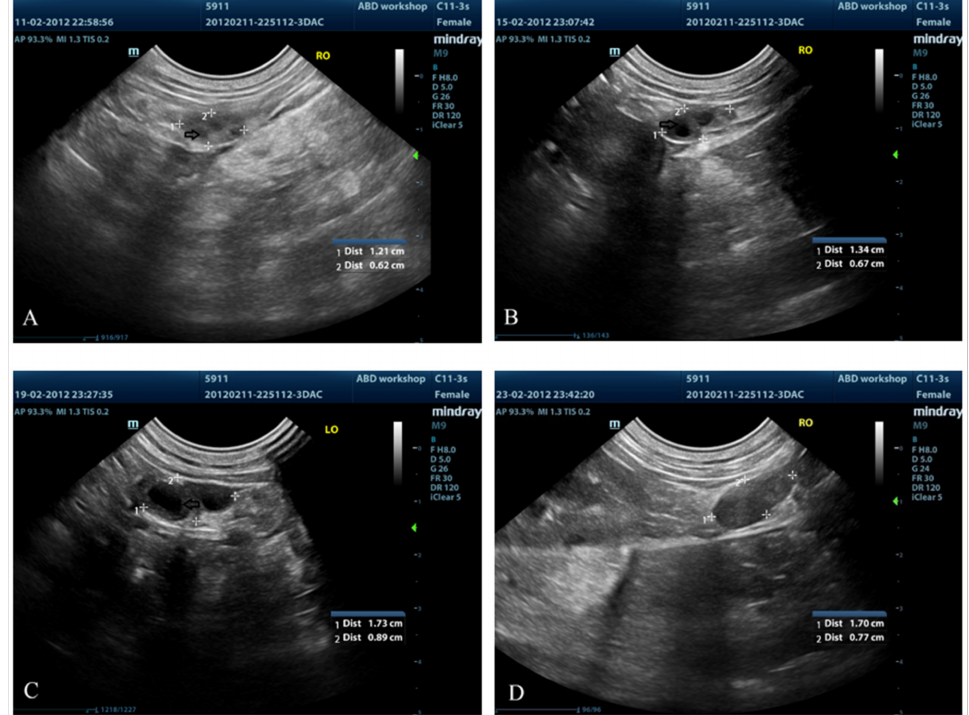
Figure 3. Examples of ovarian ultrasound images showing changes in size of the anechoic fluid-filled structures (open arrow) in a dog on day 6 ( A ), day 10 ( B ), day 14 ( C ) and day 18 ( D ) after treatment with a 4.7 mg deslorelin